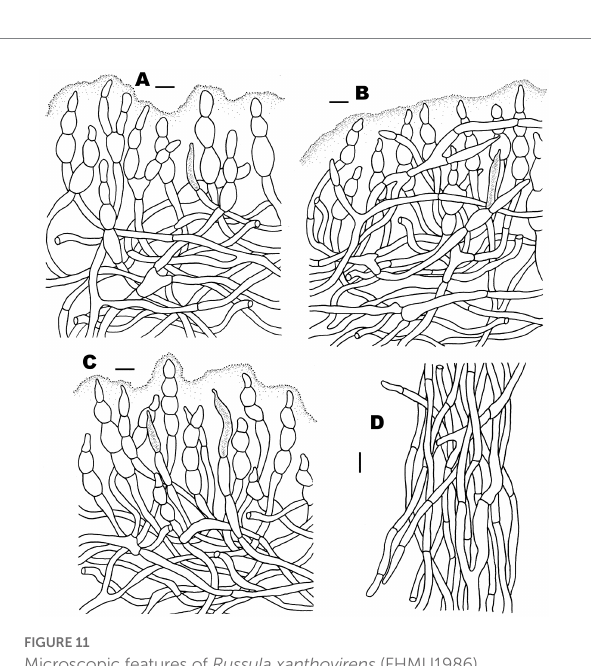
FIGURE 11 Microscopic features of Russula xanthovirens (FHMU1986). (A) Pileipellis at pileus center. (B) Pileipellis at the middle part between the center and margin of the pileus. (C) Pileipellis at pileus margin. (D) Stipitipellis. Scale bars = 10 μ m. Drawings by Y. X. Han.